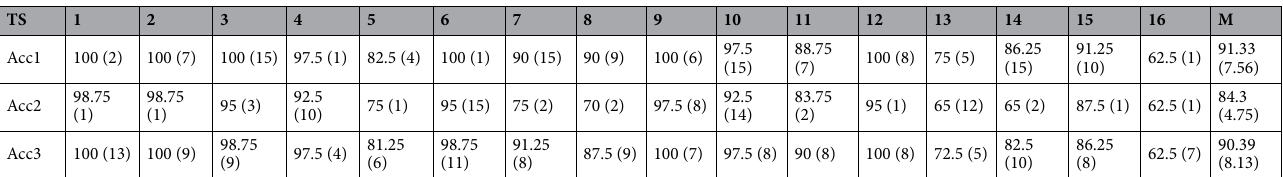
Table 1. The classification accuracies (%) of the 16 target subjects (TS) and their mean (M) under three conditions: Acc1—the maximum accuracy achieved actually; Acc2—the minimum accuracy achieved actually; Acc3—the accuracy yielded by TL-LEDA-TSS algorithm. The digits in parentheses denote the corresponding number of source